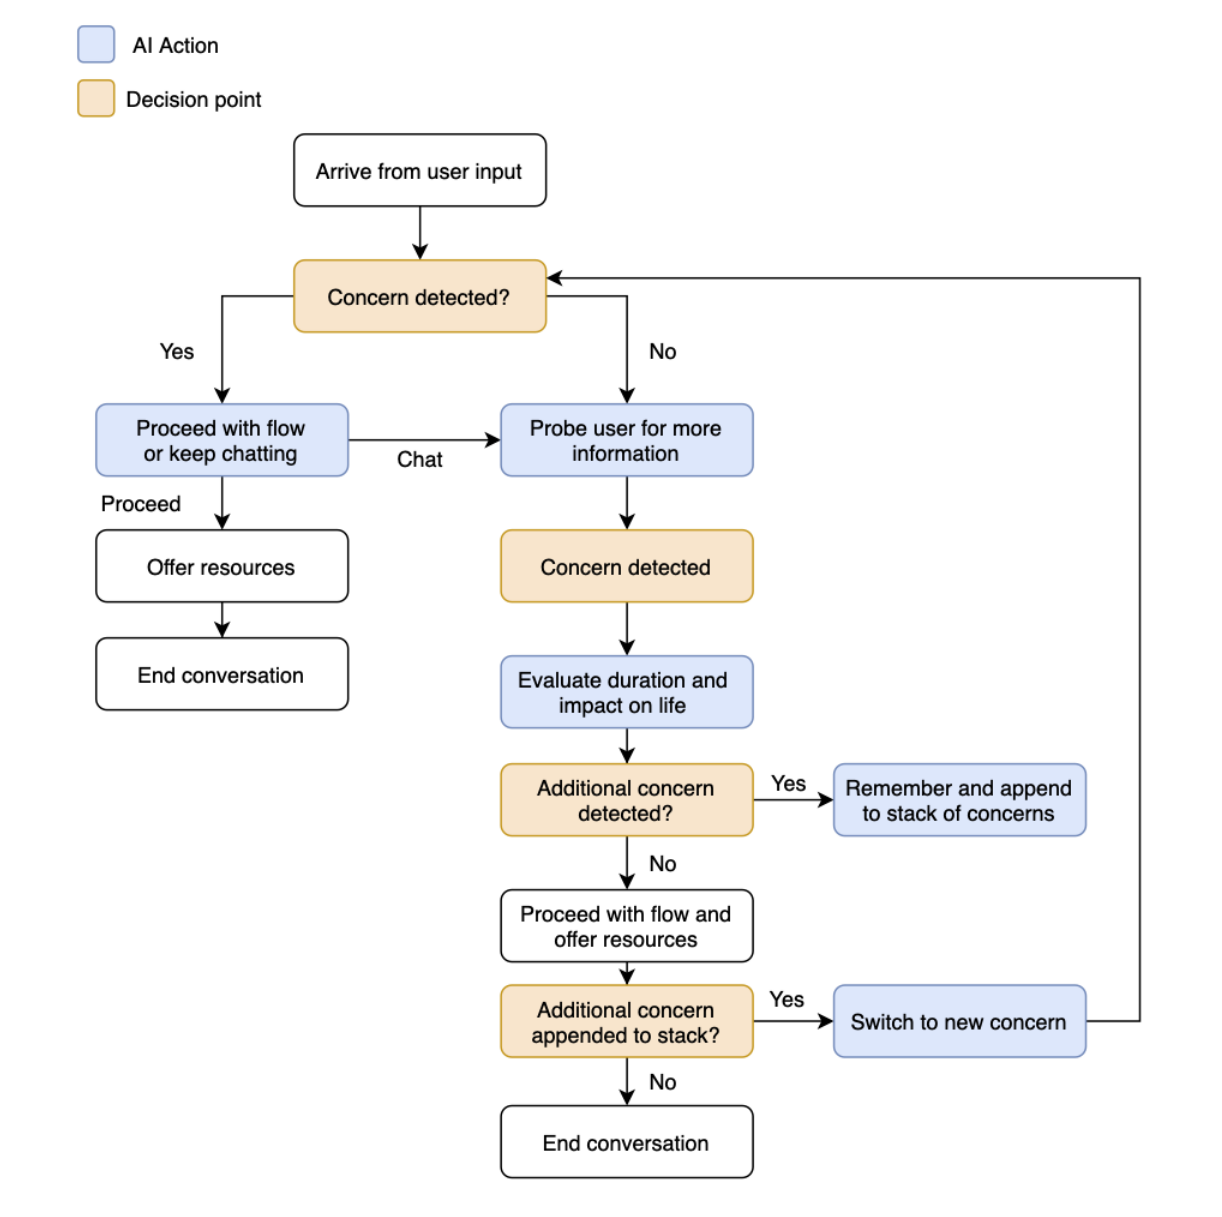
Figure 2. Demonstration of the loop-back function in the Here4U app. AI: artificial